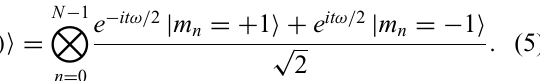
FIG. 1. Here, we demonstrate the nonintegrability of ˆ H for all values of φ , in a ( d = 1)-dimensional example with λ n , n (cid:10) = λ/( n − n (cid:10) ) 2 and periodic boundary conditions. The Wigner- Dyson distribution P ( s ) for the energy spacings s i = E i + 1 − E i and the associated r value of (cid:4) r (cid:2) ≈ 0.53 are signatures of non- integrability. All quantities are calculated in the k = 0 momen- (cid:2) ˆ = 1 magnetization symmetry sectors. For φ ∈ tum and S z n n { 0, ± π } , we must also restrict to the even reflection parity sector. (Other parameters: N = 14, ω = 1, λ =